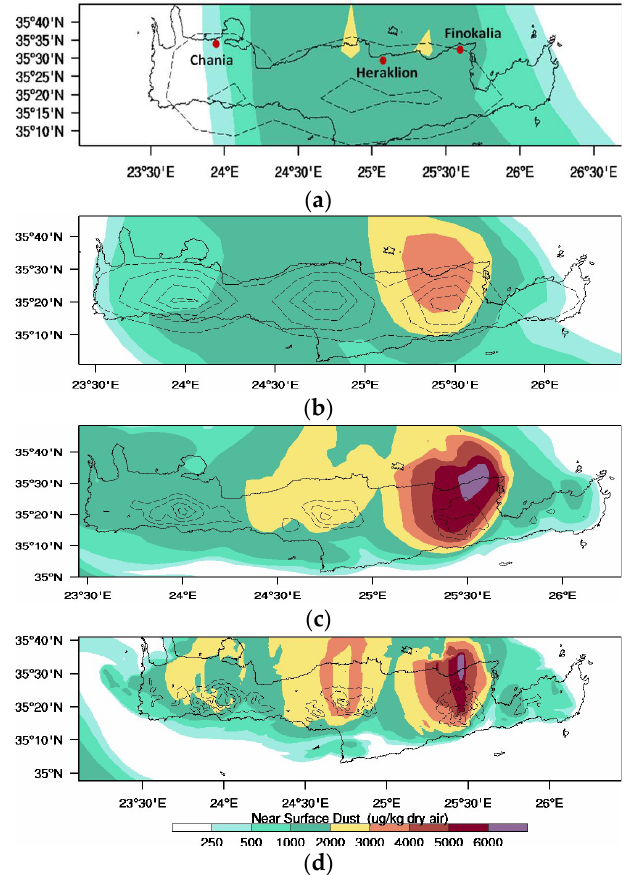
Figure 8. Surface dust concentration (μg m −3 ) and topographic contours on 22 March 2018, 1500 UTC ( a ) 24 × 24 km grid-space, topography from 200 m to 1000 m by 200 m; ( b ) 12 × 12 km grid-space, topography from 200 m to 1000 m by 200 m; ( c ) 3 × 3 km grid-space, topography from 750 m to 2000 m by 500 m; ( d ) 1 × 1 km grid-space, topography from 750 m to 2000 m by 500 m.